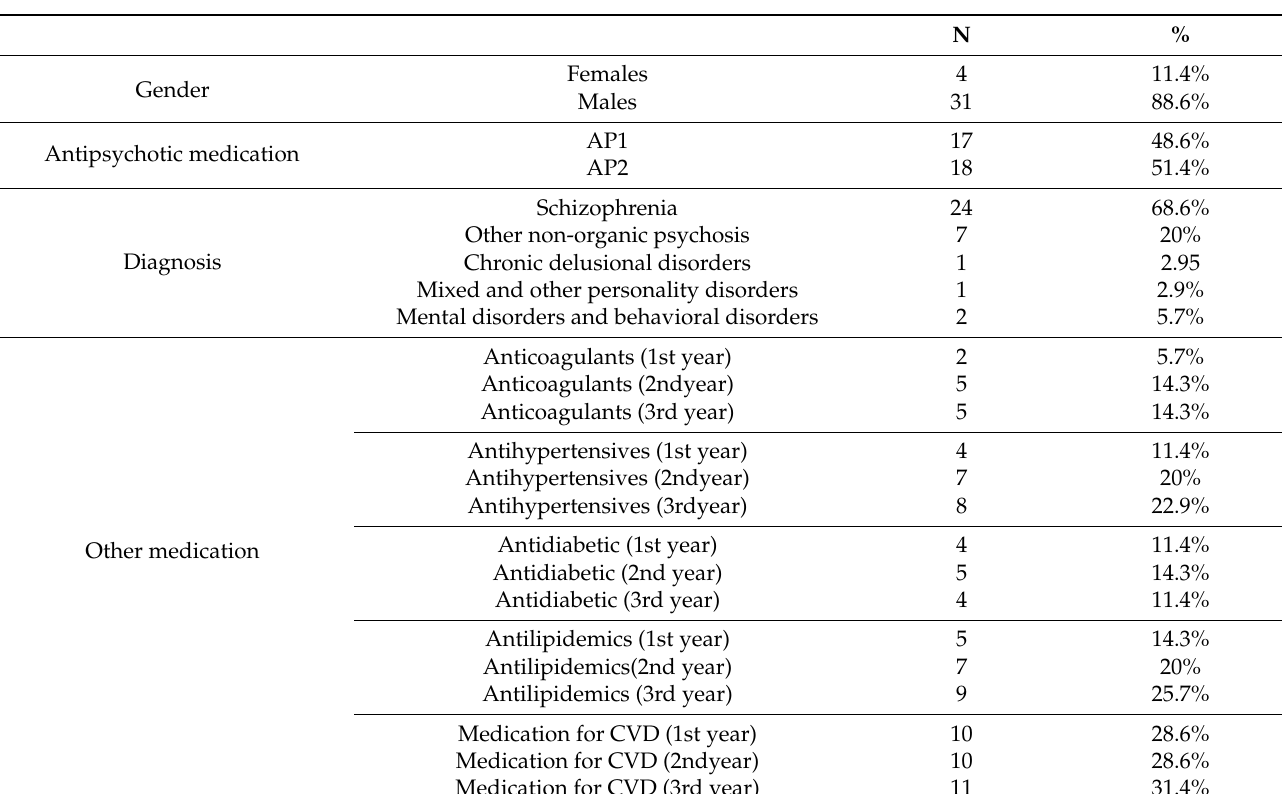
Table 1. Demographic and clinical characteristics and medication of the study population of forensic psychiatric patients (N =